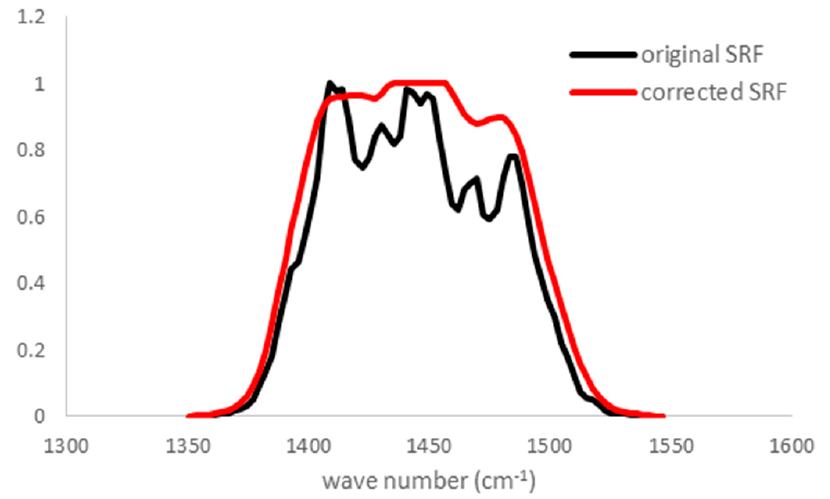
Figure 13. Operational and corrected SRF of GMS-5/VISSR WV channel. Corrected radiance was suggested by Bréon et al. [22].